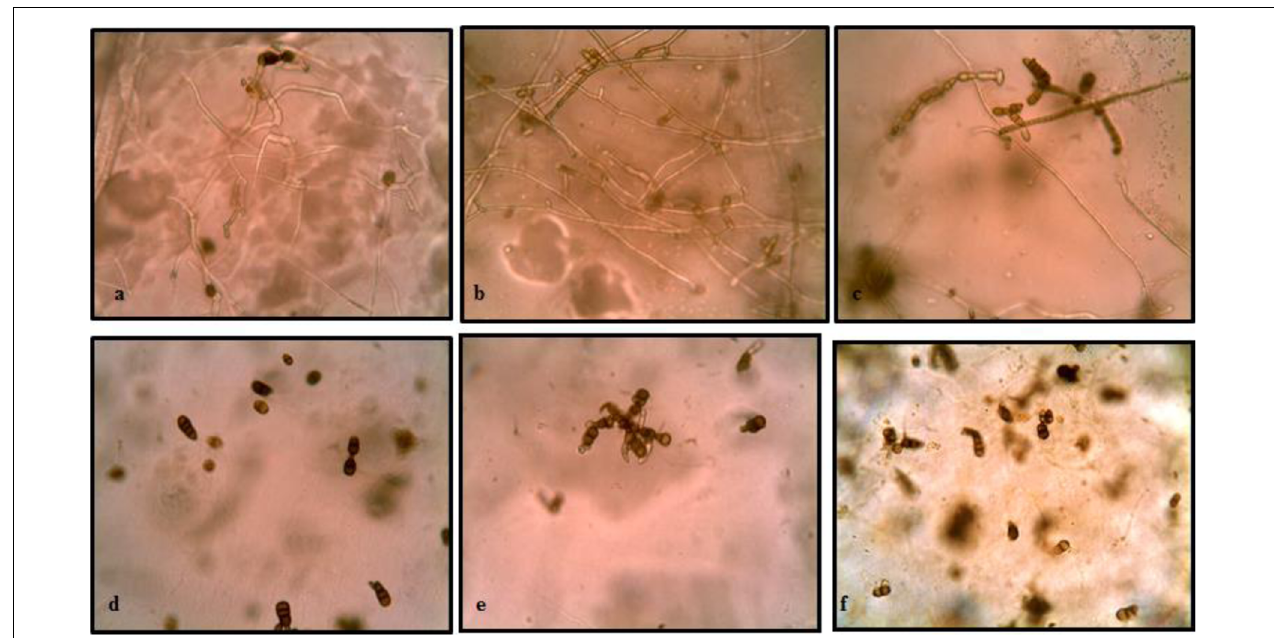
FIGURE 3 | Effect of soil inoculation with S. hydrogenans strain DH16 on germination of A. brassicicola spores. Spore germination after 2 days in (a) uninoculated control soil (d) streptomycete inoculated soil (inhibited germination of spores); (b) formation of hyphal threads in control soil (e) small restricted germ tubes in inoculated soil, after 4 days; (c) New sporulation in control (f) distortion of germ tubes in treated soil, with further incubation upto 6 days.